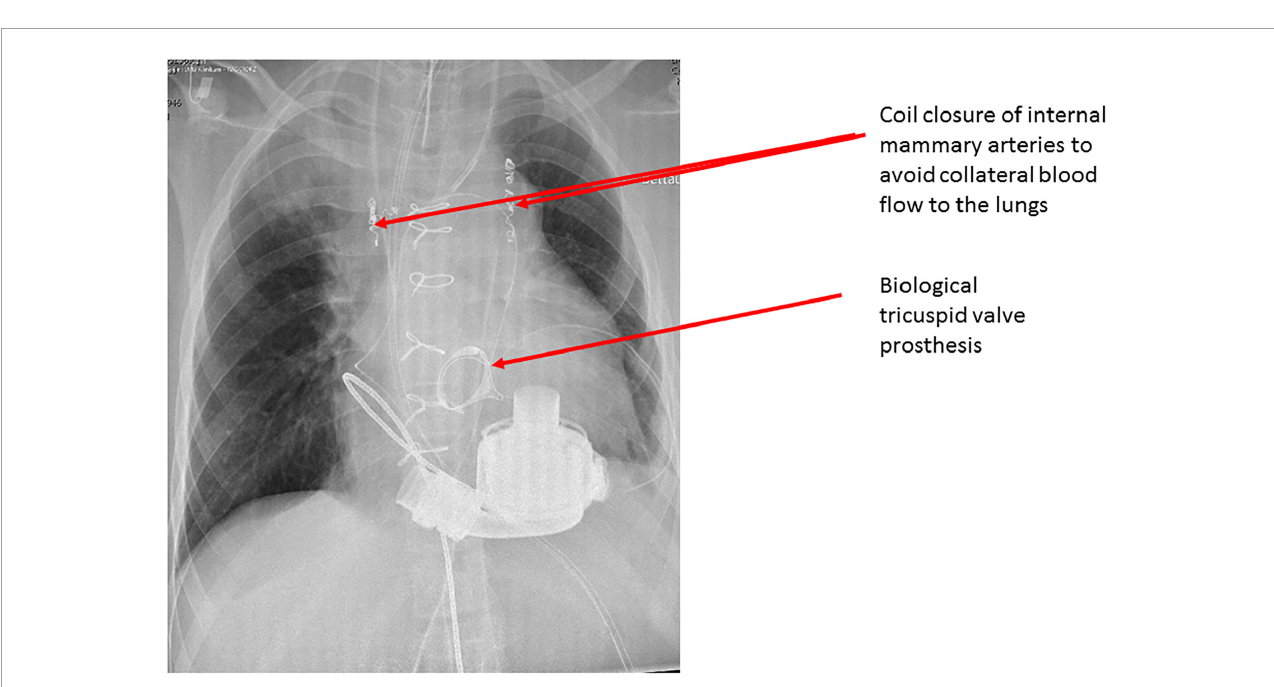
FIGURE4 Postoperative chest x-ray showing adequate positioning of the Heart Mate 3 device in the right ventricle as well as the tricuspid valve bioprosthesis.